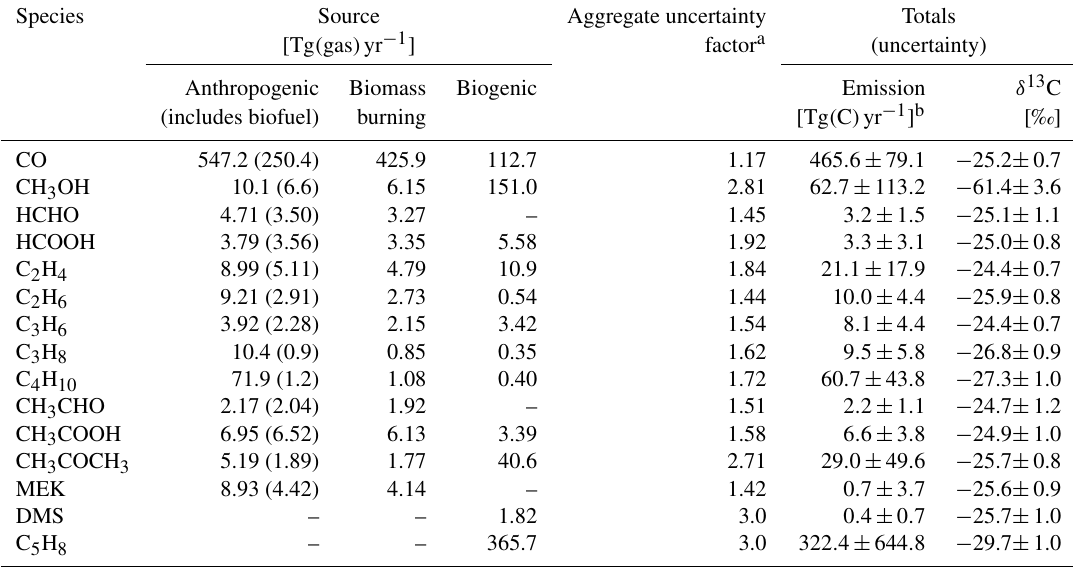
Table 5. Surface emission sources in the EMAC (EVAL 2 set-up). Species